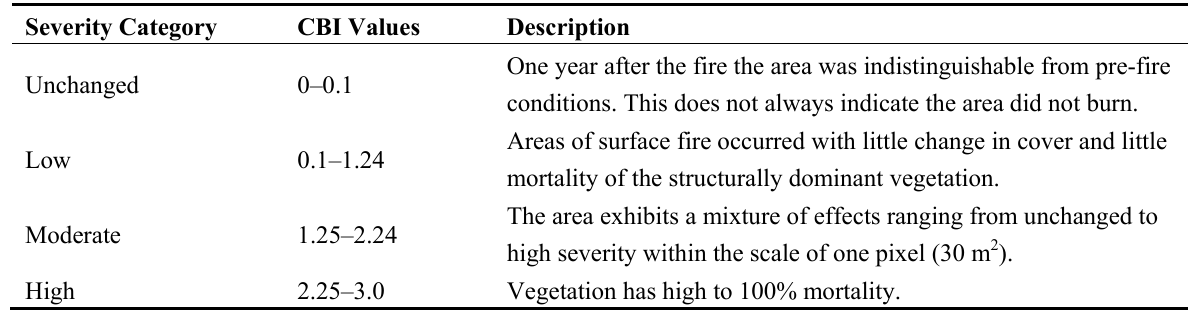
Table 6. CBI severity category definitions *